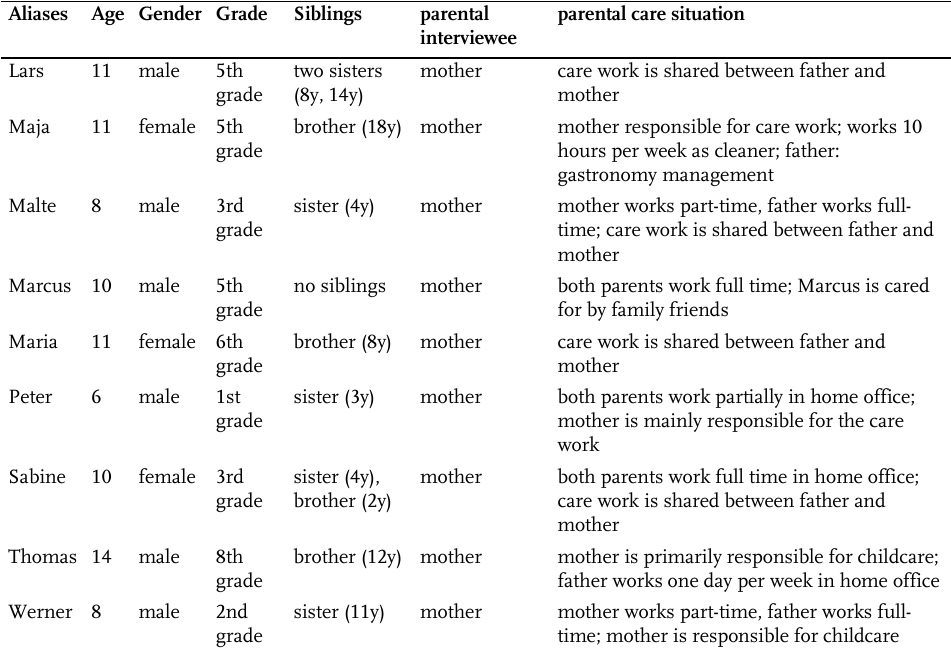
Table A.1 : Composition of the qualitative sample